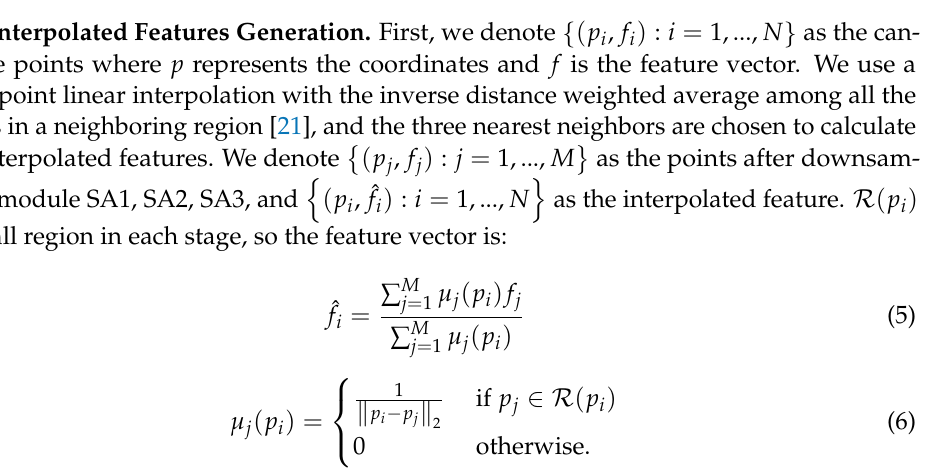
Figure 3. Illustration of the auxiliary network. The features of candidate points are concatenated by different